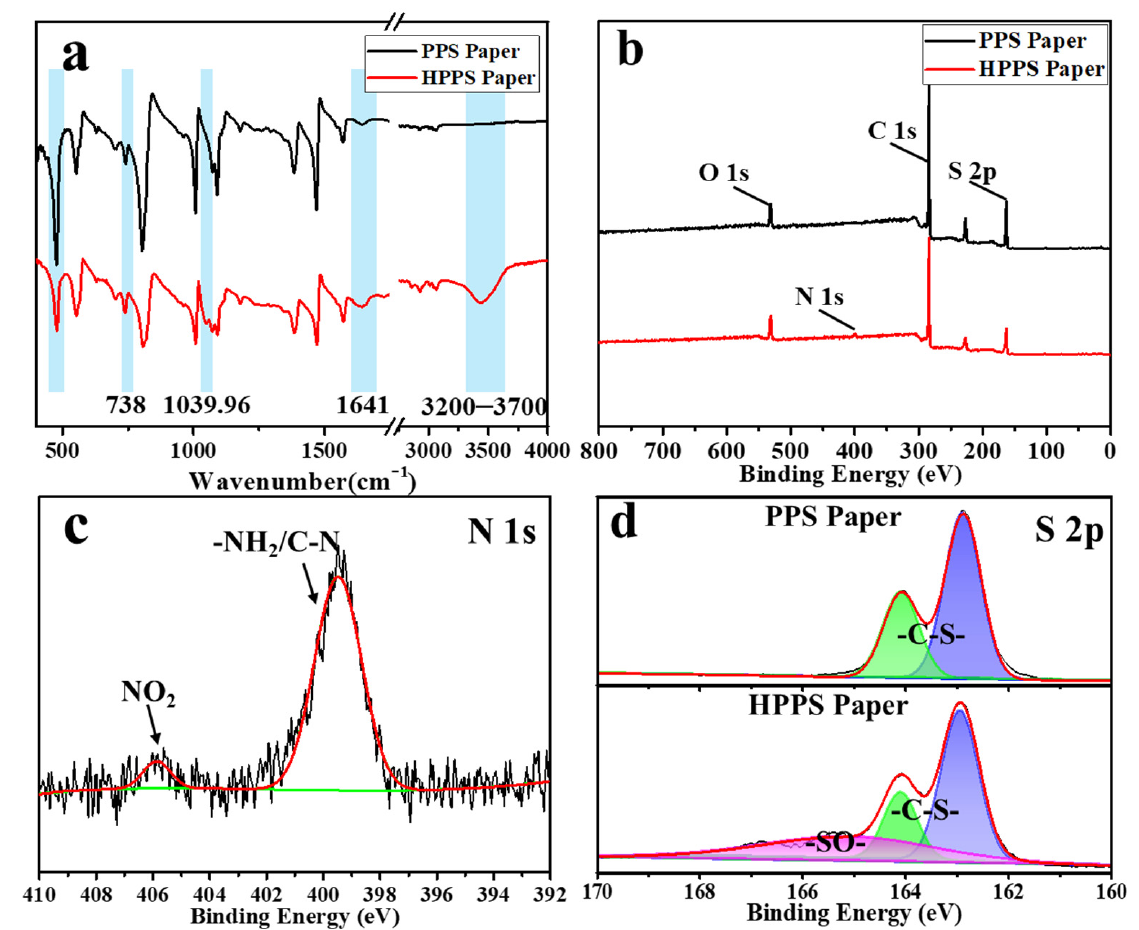
Figure 4. FT-IR spectrum ( a ) and XPS survey spectra ( b ) of PPS and HPPS papers, ( c ) N 1s high- resolution spectra of HPPS paper, ( d ) S 2p high-resolution spectra of PPS and HPPS papers.